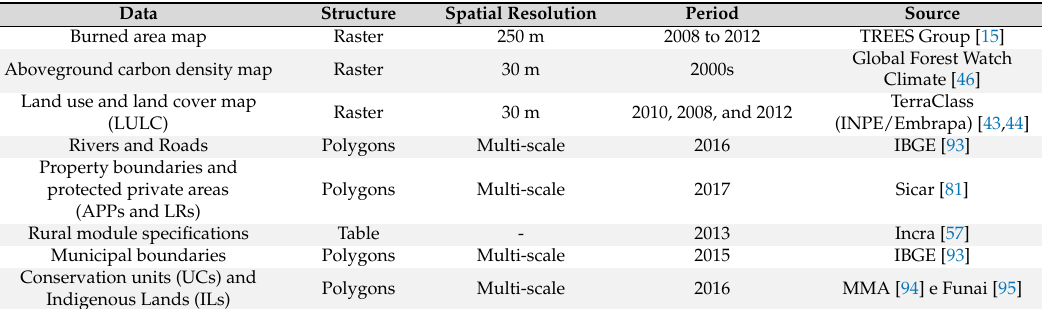
Figure A1. Location of the study area. Table A1. Summary of the spatial dataset used to develop the present work.